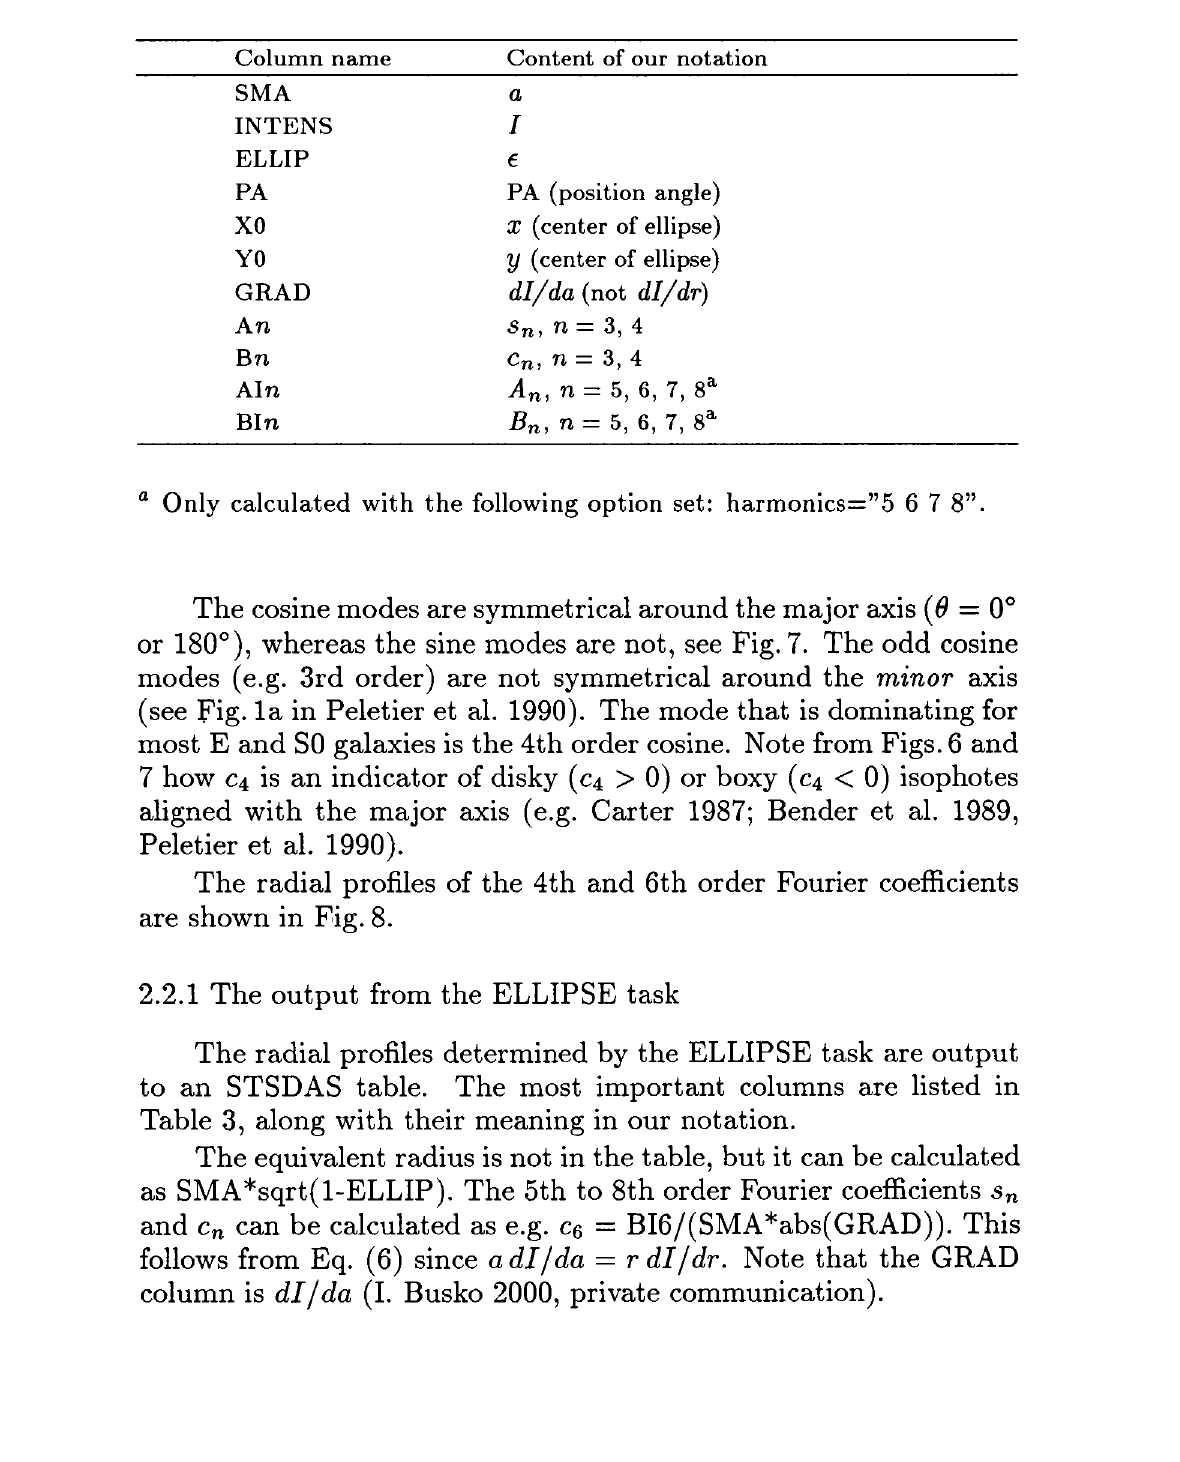
Table 3. Output columns from